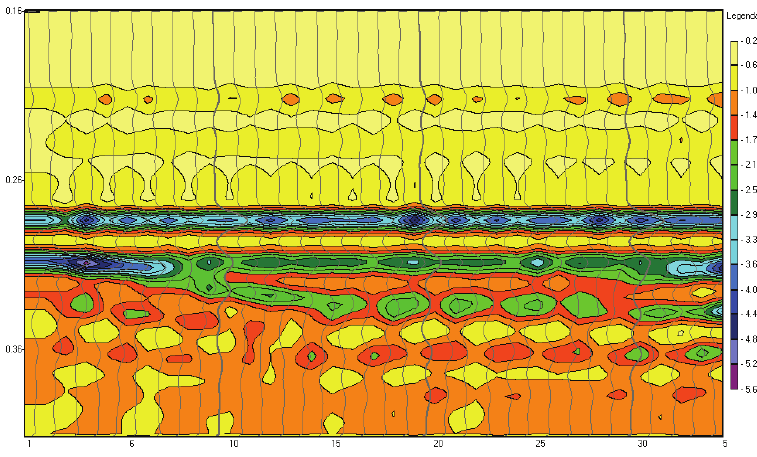
Fig. 9. Synthetic pseudoimpedance acoustic section; signal parameters: dominant frequency f 0 = 40 Hz, initial phase φ 0 = 0, the ratio of dominant frequency to dumping factor f 0 / β = 1, noise